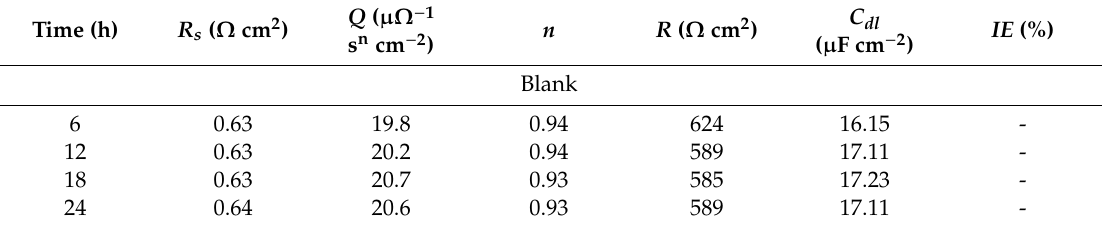
Table 5. Electrochemical impedance parameters for pure aluminium in a 1-M HCl solution with and without the presence of various concentrations of GG at 25 ◦ C after 6, 12, 18, and 24 h of immersion. Time (h) R s ( Ω cm 2